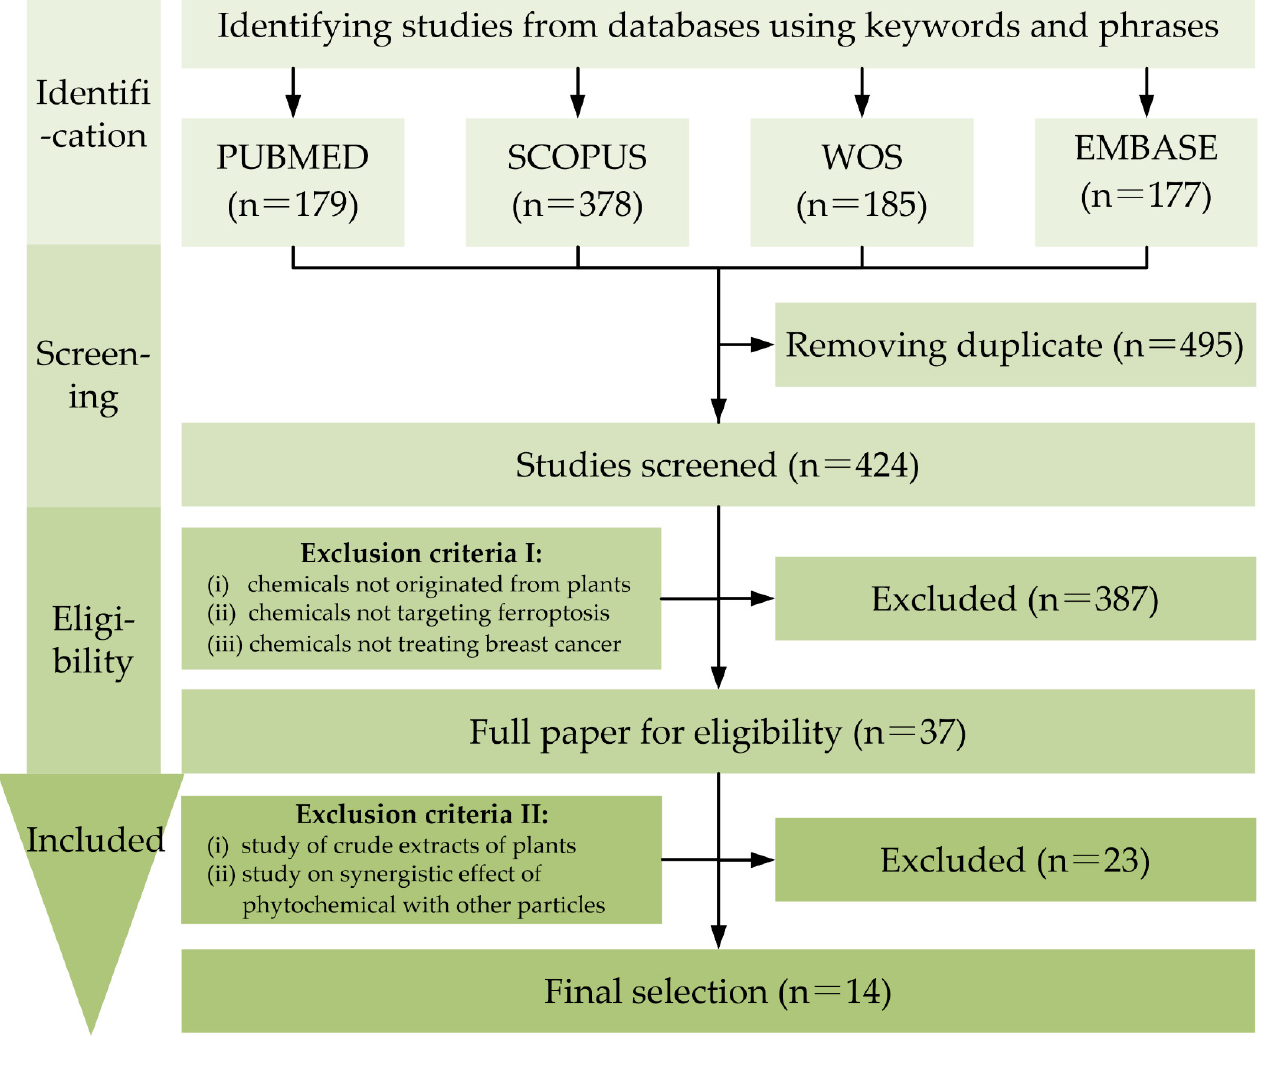
Figure 1. Flowchart of study selection for this review.